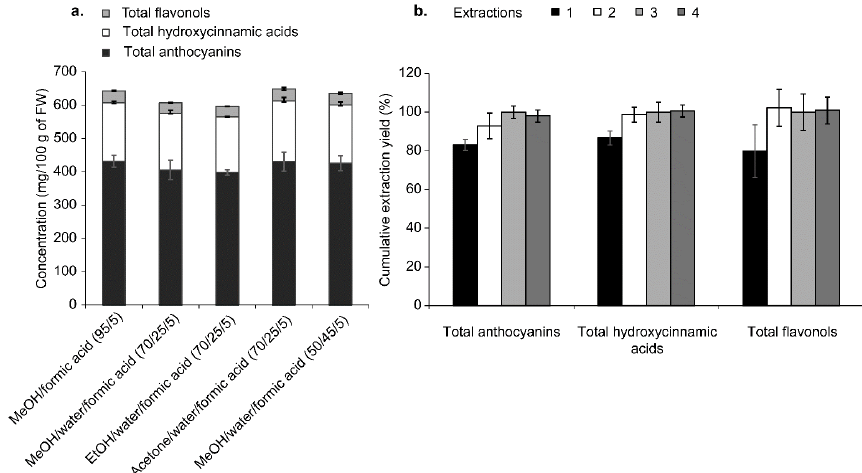
Fig. 1: Extraction yields of phenolic compounds summarized as total flavonols, hydroxycinnamic acids, and anthocyanins from black chokeberry cv. `Viking´ according to extraction solvent (a) and the number of repeated extractions (b) Footnote-1: Values represent means ± standard deviations of six replicate measurements. Footnote-2: 1, 2, 3, and 4 in b. indicate the number of repeated extractions. Footnote-3: The results are based on the HPLC method Footnote-4: Relative extraction yields are standardized to the maximum concentration achieved for each compound